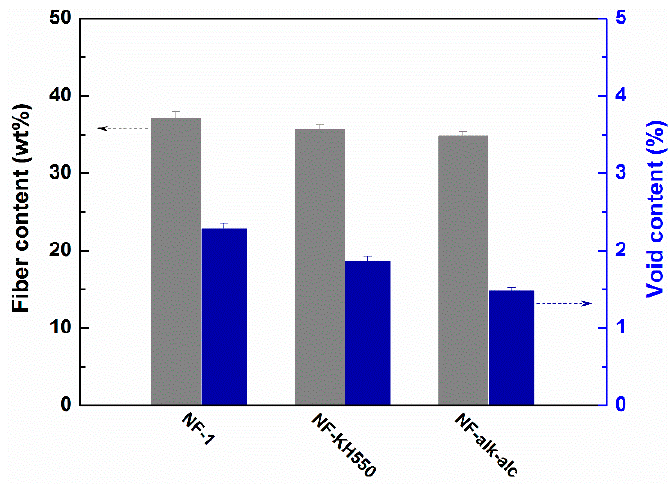
Figure 10. The fiber content and the void content of different modified ramie fabrics reinforced APA-6 composites.